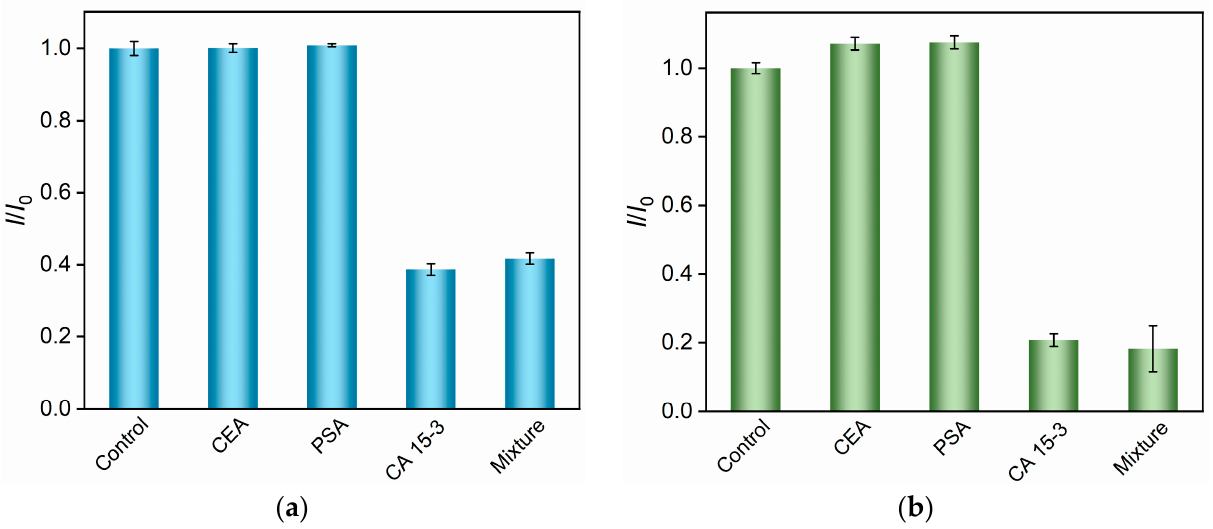
Figure 6. Relative ratio of ECL intensity ( a ) and DPV current ( b ) before ( I 0 ) and after ( I ) incubation with buffer (Control), CEA (500 ng/mL), PSA (500 ng/mL), CA 15-3 (25 U/mL), or a protein mixture (25 U/mL CA 15-3 + 500 ng/mL other proteins). The error bars represent the standard deviation of three measurements under the same condition.